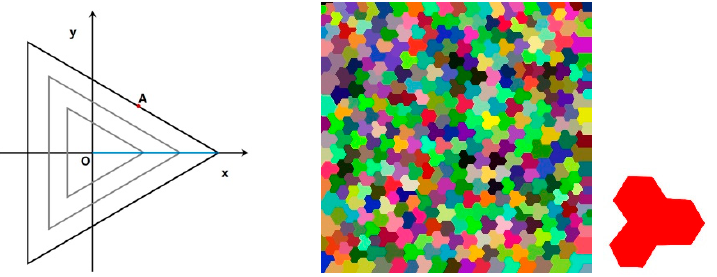
Figure 7. Left: equidistant line distance. Right: the Voronoi diagram and the Voronoi region shape (lower right corner) by the equidistant line distance.